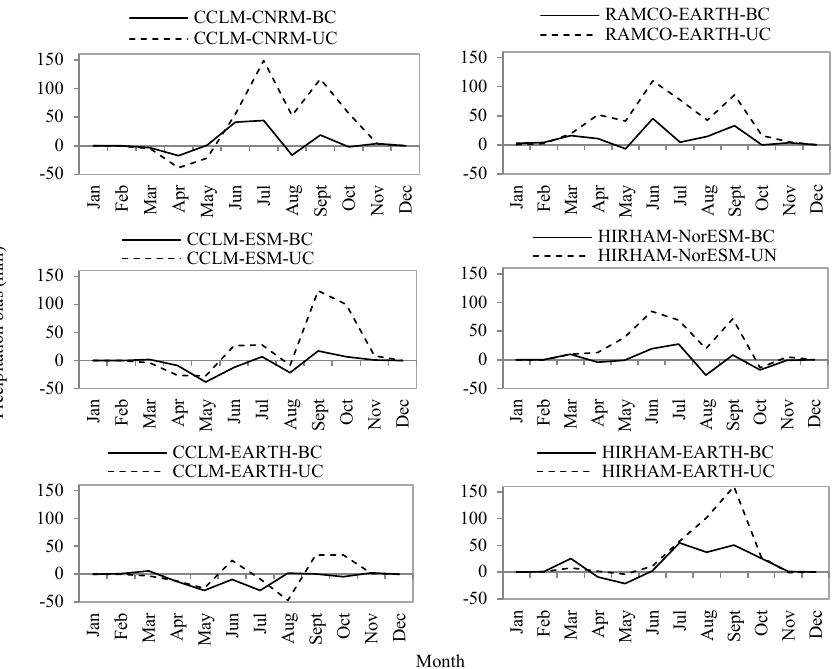
Figure 2. Absolute precipitation bias (corrected and not corrected) for the model ensemble compared to the observed data for the period of 1991–2000. The transfer functions were calibrated for the period